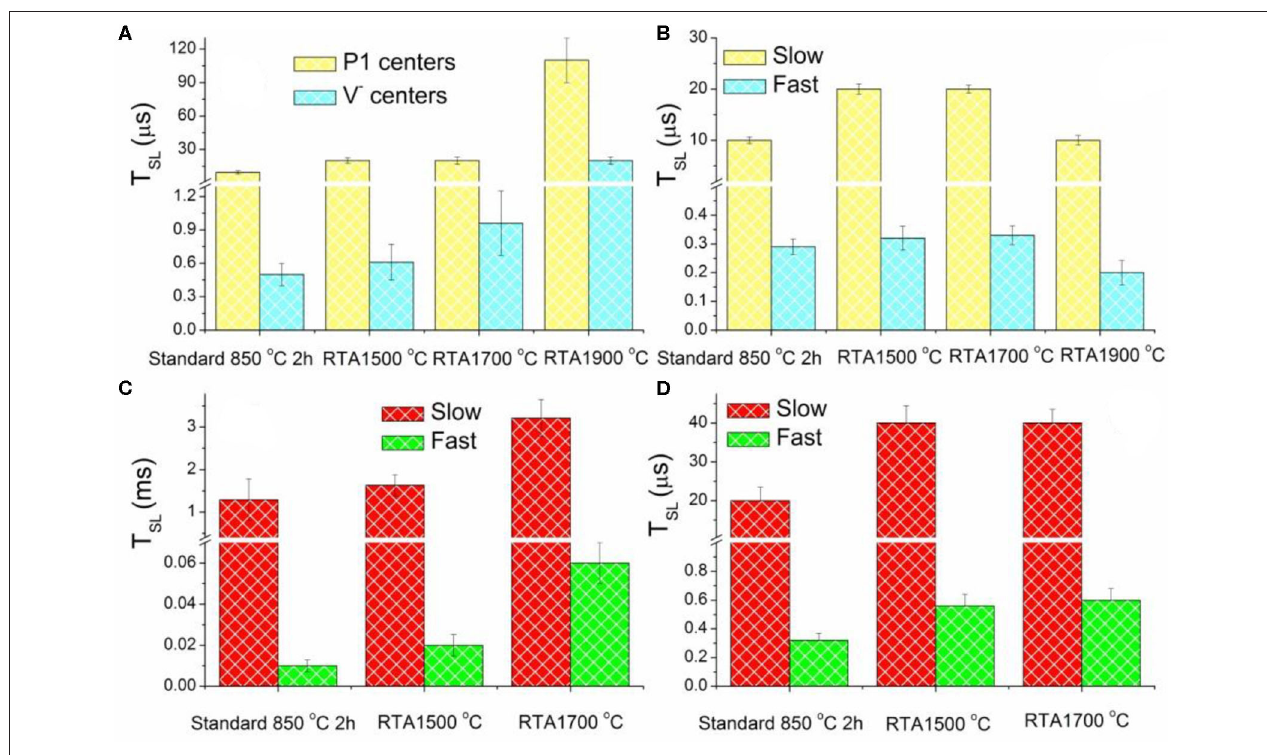
FIGURE 5 | Electron spin-lattice relaxation times T SL estimated for EPR lines attributed to: (A) primary defects P1 and V − centers (measured at RT); (B) Ni − s centers (measured at T = 50K); (C) low field “allowed” (C) and “forbidden” (D) transitions between Zeeman sublevels of the triplet NV − centers (measured at RT).